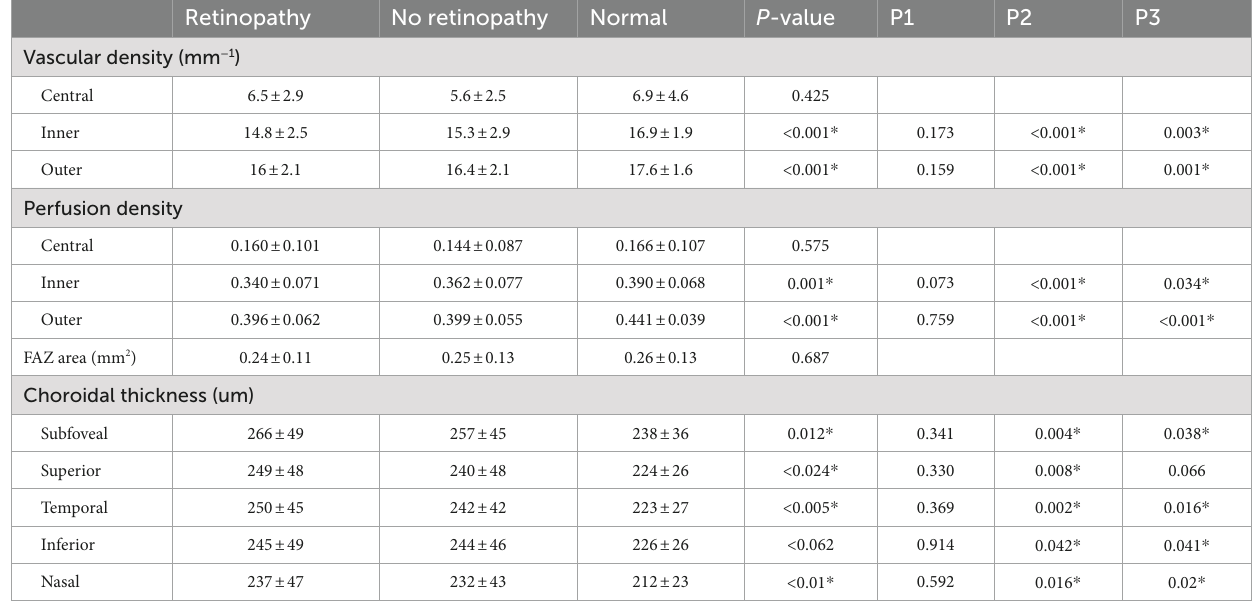
TABLE 3 Optical coherence tomography angiography (OCTA) analysis results in different study